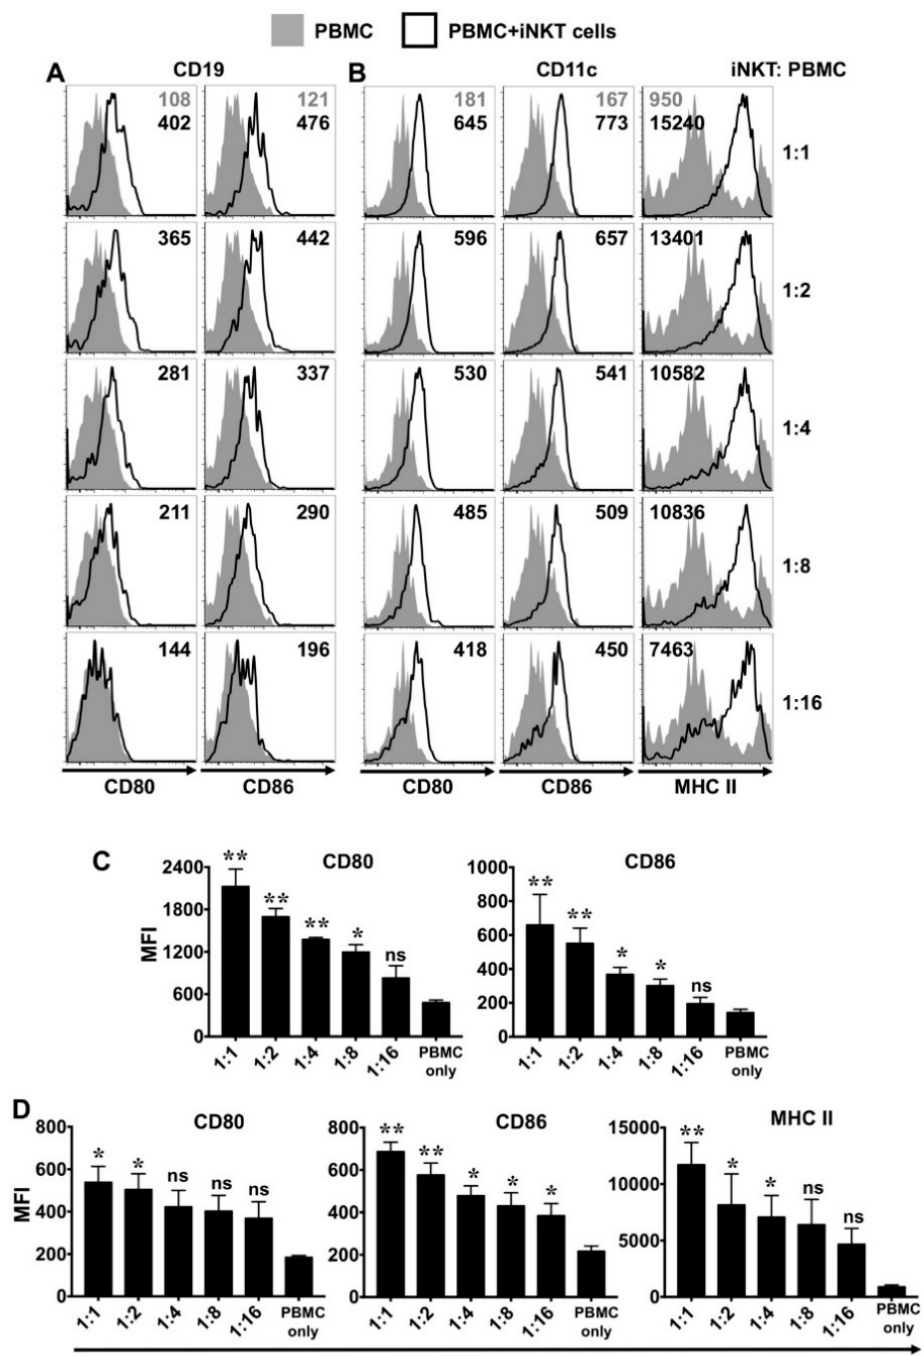
Figure 7. NKTT320 promotes the increased expression of co-stimulatory molecules and MHC class II (MCH II) on antigen-presenting cells. ( A , B ) Freshly isolated human iNKTs were mixed with autologous PBMCs at different ratios, as indicated. Control wells had PBMCs only. Cells were added to plate-bound NKTT320 mAb (1.0 μ g/mL). After 24 h, cells were harvested and analyzed for surface expression of co-stimulatory molecules (CD80, CD86) and MHC II expression on CD19+ B lymphocytes ( A ) and CD11c+ myeloid cells ( B ). Representative histograms from one of three independent experiments are shown. Numbers in the histograms indicate MFI. ( C , D ) Pooled data (mean ± SEM) from three independent experiments show the MFI for CD80 and CD86 gated on CD19 + cells ( C ), as well as the MFI for CD80, CD86, and MHC II expression on CD11c + cells ( D ). Statistical significance determined using one-way ANOVA. For each of the analysis, all the groups were compared to control wells (PBMC only). * p < 0.05, ** p < 0.01, ns: not